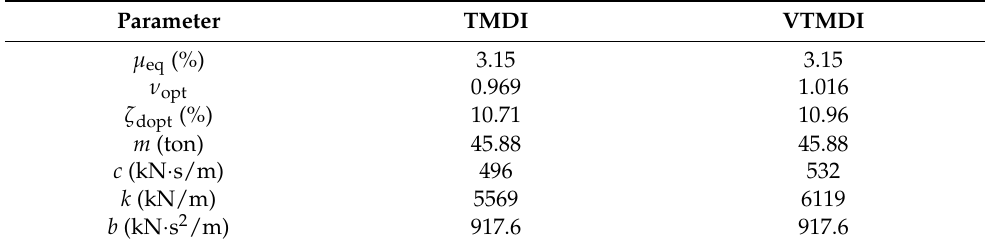
Table 7. Determined IVA parameters for the chimney